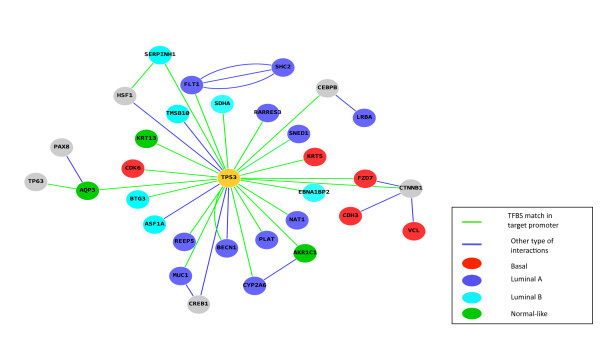
Predicted functional relationship of TP53 in different molecular subtypes of breast cancer. Figure shows predicted interactions of genes or proteins with TP53. Source: Bibliosphere pathway database. (green edges: TF motif match found in target promoter of target genes; genes associated with basal subtype are shown as red nodes, ones with luminal A in blue, luminal B in cyan and normal-like as green nodes.)